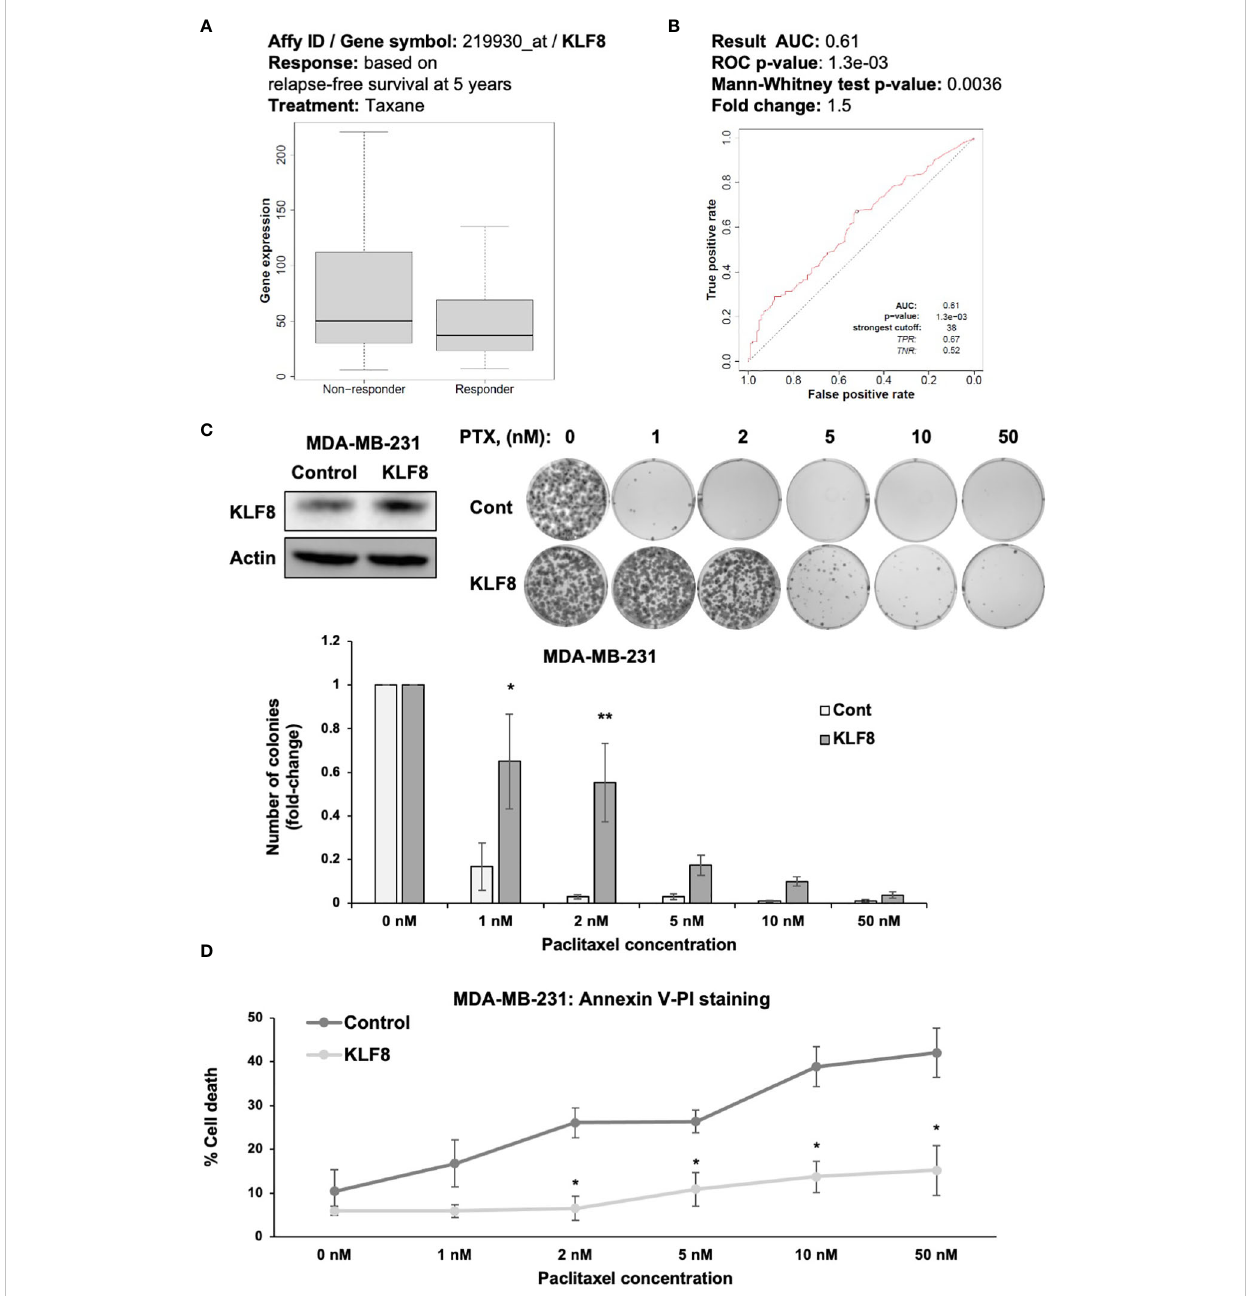
FIGURE 4 KLF8 promotes resistance to paclitaxel in breast cancer cells in vitro. (A) Data-based analysis showing KLF8 expression in breast cancer patients with differential response to taxane treatment. (B) Data-based analysis showing ROC-plot of KLF8 expression in different groups of breast cancer patients treated with taxane. (C) Lysates of MDA-MB-231 cells stably overexpressing control or with KLF8 were collected for immunoblot using indicated antibodies (top-left). MDA-MB-231 cells stably overexpressing control or KLF8, treated with increasing dose of paclitaxel for 48h, were grown in clonogenic assay for 10-14 days. Colonies were stained, counted. Representative images show stained colonies formed in the clonogenic assay after 10-14 days from MDA-MB-231 cells overexpressing control or KLF8, treated with increasing dose of paclitaxel for 48h (top-right). Quanti fi ed graph of counted colonies after 10-14 days from MDA-MB-231 cells overexpressing control or KLF8, treated with increasing dose of paclitaxel for 48h, in clonogenic assay (bottom). (D) Quanti fi ed graph showing fraction of apoptotic cells from MDA-MB-231 cells overexpressing control or KLF8, treated with increasing dose of paclitaxel for 48h. Two-way ANOVA with Holm-Sidak test reported as mean ± SEM, *p<0.05, and